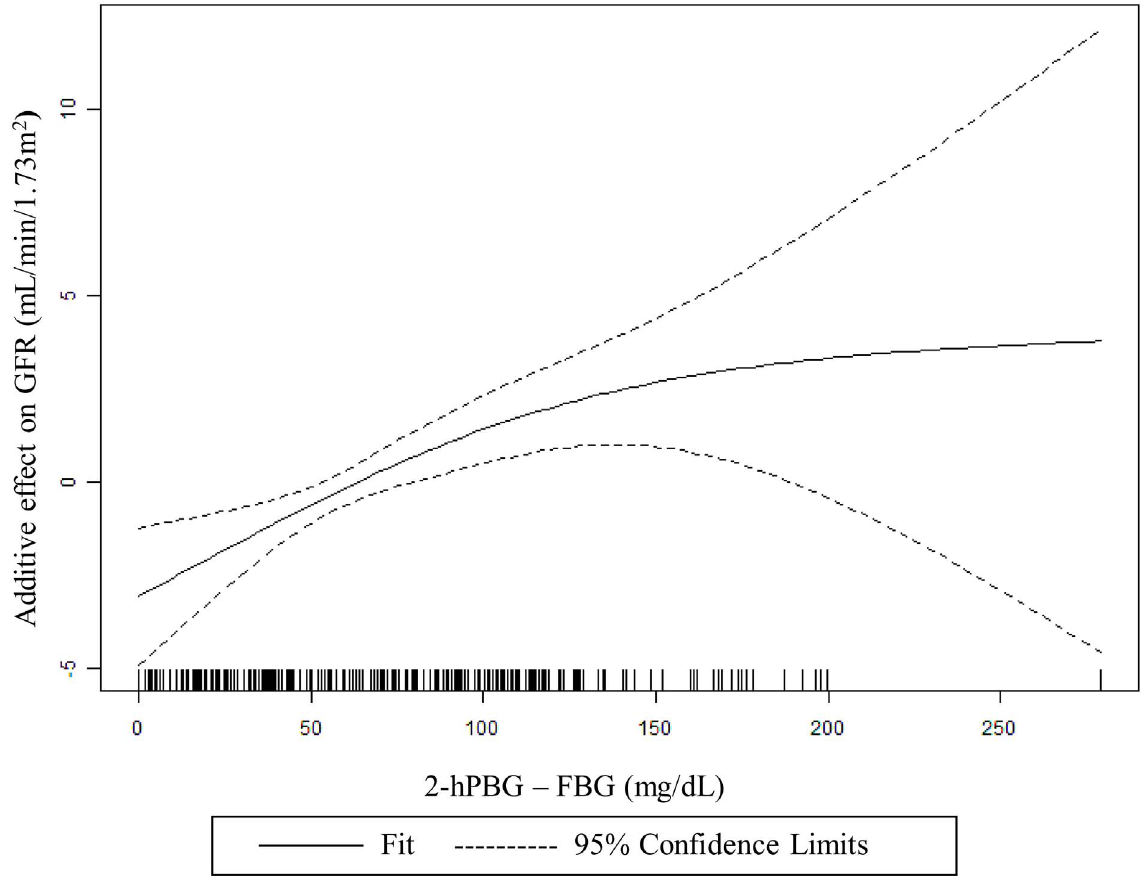
Figure 1. Nonlinear association of the difference between 2-h postload blood glucose and fasting blood glucose (2-hPBG-FBG) in association with estimated glomerular filtration rate (eGFR). The association was analyzed in a generalized additive model (df=3, P , 0.001) adjusted for age, gender, BMI, systolic BP, diastolic BP, fasting insulin, cholesterol, triglycerides, smoking, drinking and HbA1c. doi:10.1371/journal.pone.0111173.g001 PLOS ONE |